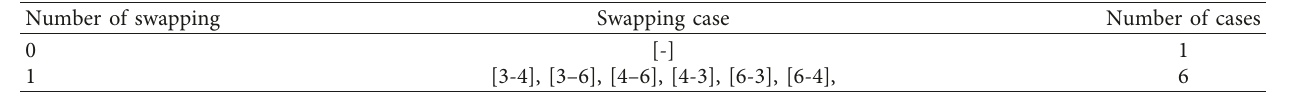
Table 4: All possible swapping cases for type 2 component.